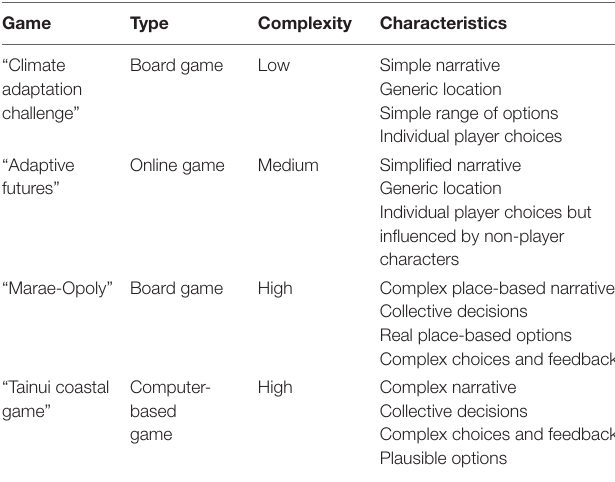
TABLE 1 | Game complexity